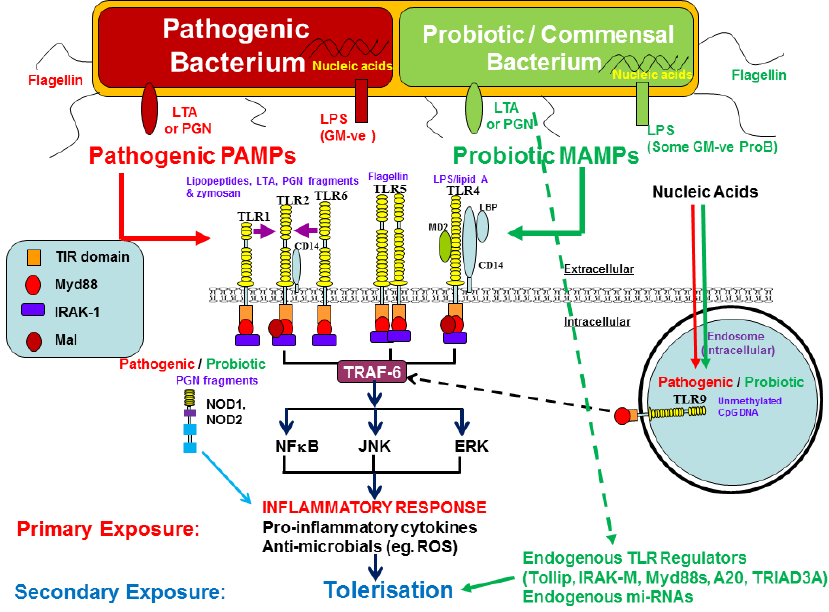
Figure 3. Immune stimulation or tolerisation?—Probiotics hold the key! Probiotics differentially modulate macrophage responses via activation and suppression of distinct pathogen sensing signaling pathways in a strain ‐ dependent manner. Both pathogenic (red) and probiotic (green) bacteria can express similar/overlapping profiles of PAMPs/MAMPs (LTA, LPS, Flagellin, PGN, DNA) through a range of PRRs including external ‐ facing TLR2 (homodimeric or heterodimerised with TLR1 or TLR6), TLR4, TLR5, and intracellular NOD1, NOD2 and endosomal TLR9. All of which can transduce immune activatory/inflammatory responses through activation of NFkB and MAPK signal pathways (indicated in red arrows). In addition, secondary exposure and chronic exposure to probiotic ‐ derived MAMPs (indicated in green arrows), induce a suppressive/tolerogenic response via the induction of endogenous negative regulators to TLR signals (Tollip, IRAK ‐ M, Myd88s, A20, TRIAD3A and miRNAs) that inhibit NFkB and MAPK pathways. Finally, recognition of PGN and its breakdown products through NODs ‐ 1 and ‐ 2 (indicated in a blue arrow) can have both a positive and negative effect on the inflammatory response that may be determined by selective NOD receptor utilisation or specific structural differences between PAMPs and MAMPs. TIR domain and TLR signal adaptor molecules are indicated in the blue key box.